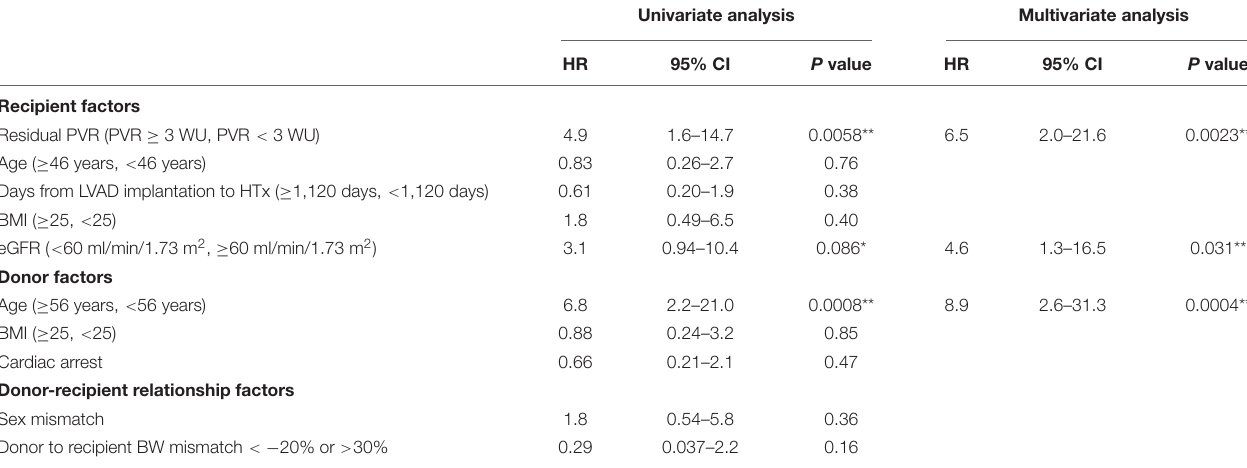
TABLE 5 | Univariate and multivariate Cox proportional analysis of factors that determined the risk of the composite event of admission for heart failure, diuretic use or elevated intracardiac pressure (mRAP ≥ 12 mm Hg or mPCWP ≥ 18 mm Hg). Univariate analysis Multivariate analysis HR 95% CI P value HR 95% CI P